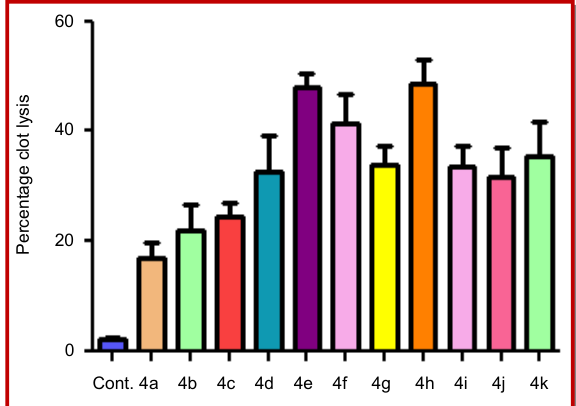
Figure 4: Mean percentage cot lysis exhibited by